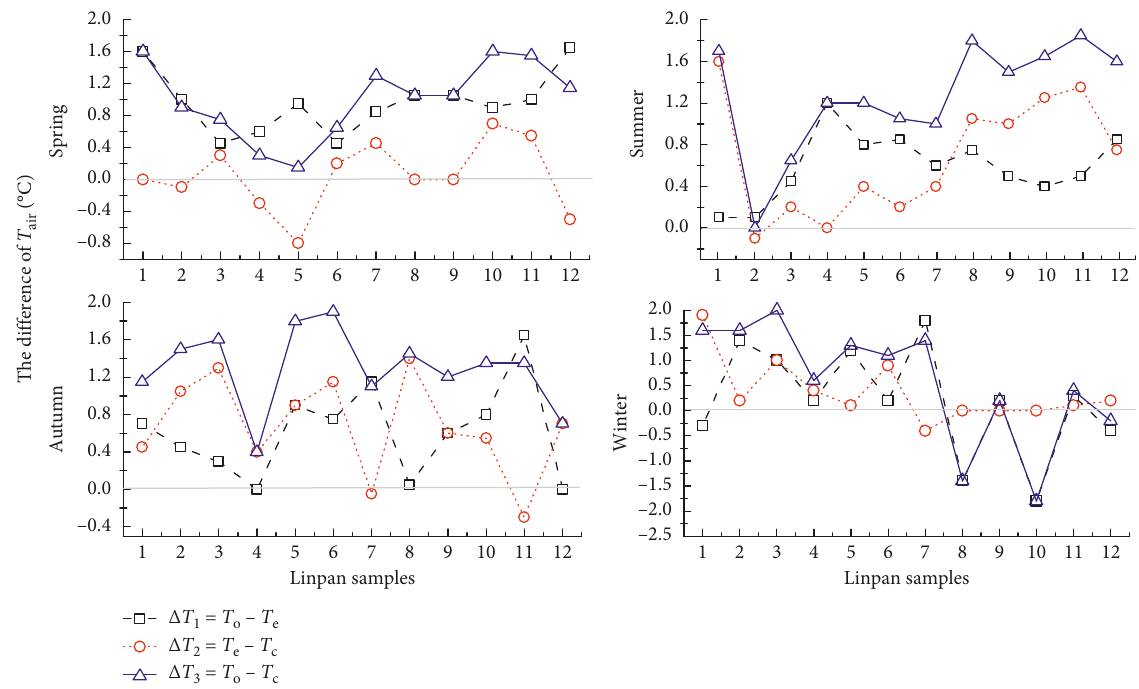
Figure 5: The seasonal temperature difference of Linpan